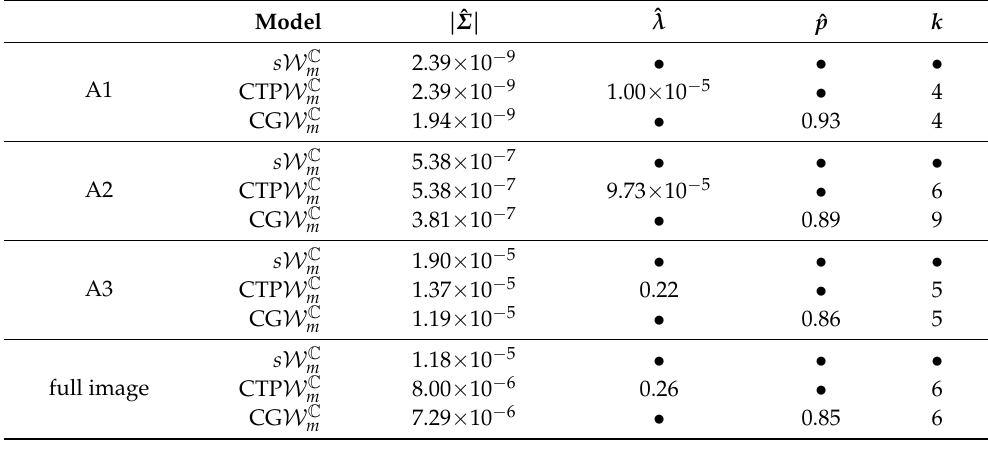
Table 4. MLE for the s W C m ( L , Σ ) , CTP W C m ( λ , L , Σ ) , and CG W C m ( p , L , Σ ) distributions with L = 4.